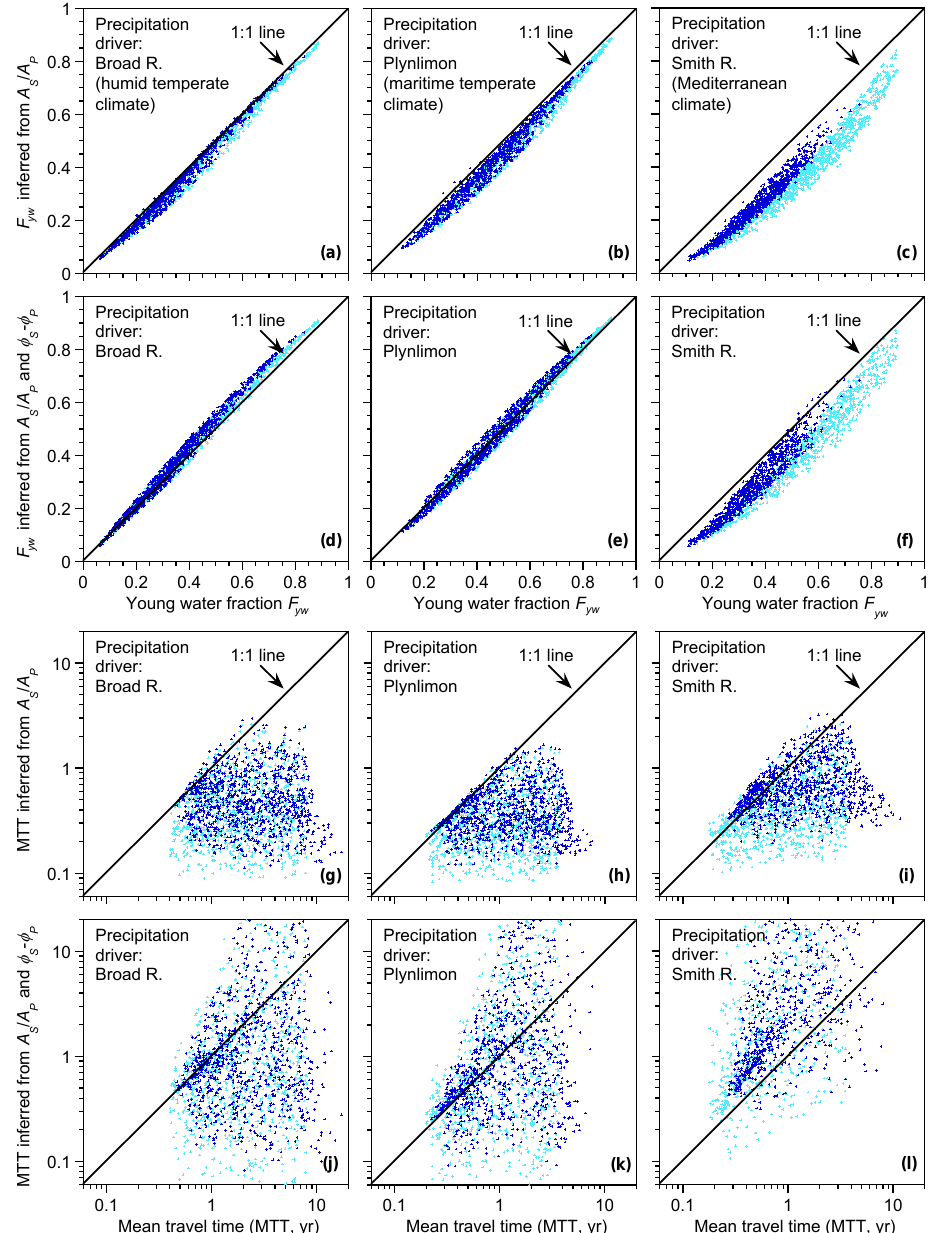
Figure 7. Young water fractions ( F yw , top panels) and mean transit times (MTT, bottom panels – note log scale) in streamflow from the two-box model. Upper panels compare the average F yw in discharge, determined by age tracking within the model (on the horizontal axes) with the seasonal tracer cycle amplitude ratio A S /A P (a–c) , and with F yw inferred from the tracer cycle amplitude ratio A S /A P and phase shift ϕ S − ϕ P (d–f) . Lower panels compare the average MTT in discharge (again from age tracking) with MTT inferred from the tracer amplitude ratio (g–i) and from amplitude ratio and phase shift (j–l) . Light blue points show flow-weighted average F yw values and MTTs for each simulation, compared to estimates from flow-weighted fits to seasonal tracer cycles. Dark blue points show unweighted average F yw values and MTTs, compared to estimates from unweighted fits to seasonal tracer cycles. Panels show results from 1000 random parameter sets and three contrasting precipitation drivers: Broad River (humid, temperate, with very little seasonality), Plynlimon (wet maritime climate with slight seasonality), and Smith River (Mediterranean climate with pronounced winter-wet, summer-dry seasonality). Seasonal tracer cycle amplitudes generally predict the average young water fraction, although they exhibit some systematic bias under strongly seasonal precipitation regimes like Smith River, where seasonal cycles in precipitation volume are correlated with seasonal cycles in tracer concentration. By contrast, mean transit-time estimates from seasonal tracer cycles are highly unreliable in all precipitation